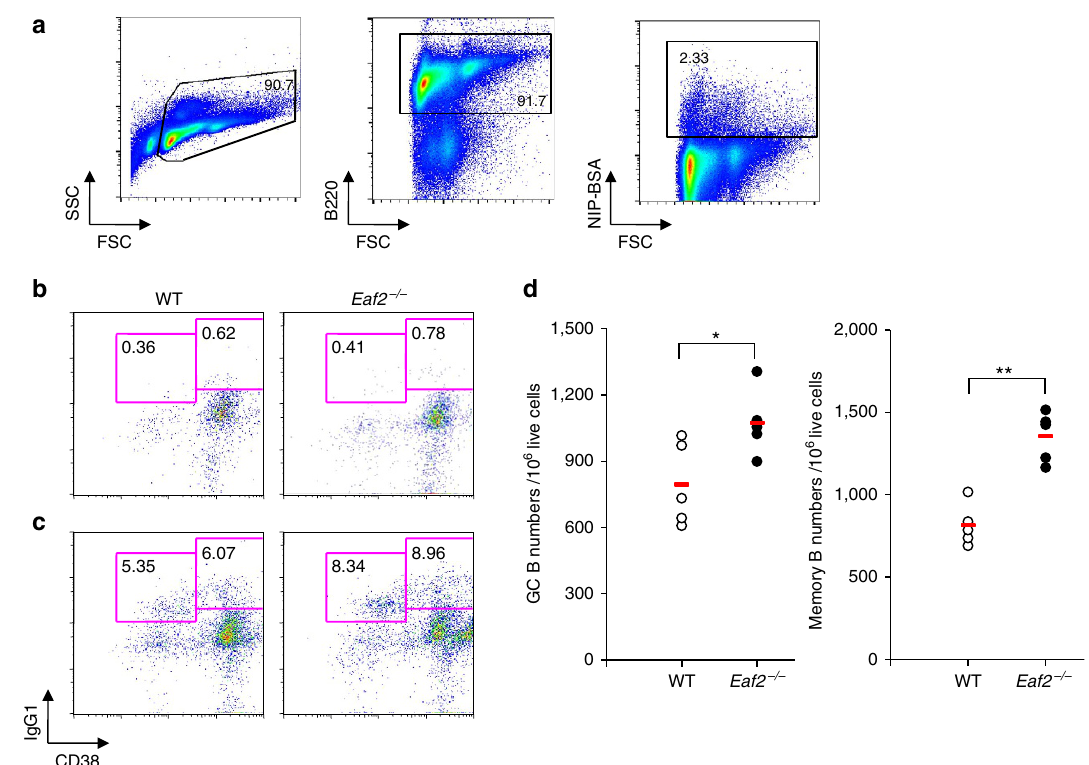
Figure 4 | Increased frequency of Ag-specific GC and memory B cells after immunization. Spleen B cells were purified 2 weeks after immunization with NP–CGG and stained with FITC-labelled IgG 1 , PE-conjugated NIP 26 -BSA, APC-conjugated anti-CD38 and PE-Cy7-labelled anti-B220. GC B (NIP binding/ B220 þ /IgG 1 dull /CD38 dull ) and memory B cells (NIP binding/B220 þ /IgG 1 high /CD38 þ ) were enumerated. ( a ) Gating strategy for the analysis of GC B and memory B cells. The live B220 þ NIP-binding cells were analysed for CD38 and IgG 1 expression. ( b ) Before immunization. ( c ) Two weeks after immunization. Left panel, WT mice; right panel, Eaf2 (cid:3) / (cid:3) mice. ( d ) The tabulated results of five pairs of WT and Eaf2 (cid:3) / (cid:3) mice. Left, GC B cells; right, memory B cells. Open circles, WTmice; Solid circles, Eaf2 (cid:3) / (cid:3) mice. The red bar indicates the mean of five mice. * P o 0.05; ** P o 0.01 (unpaired t